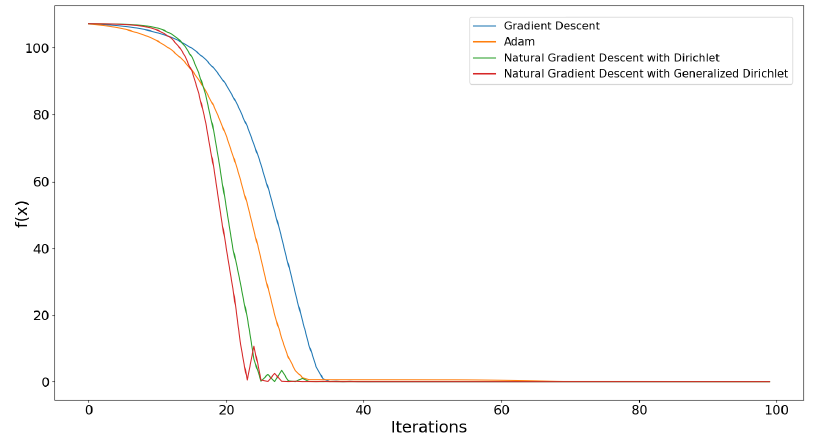
Figure 3. The rate of convergence on extended trigonometric function using various